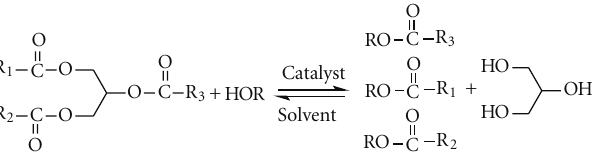
Figure 1: Schematic diagram of triacylglycerol transesterification by alcoholysis, in the presence of catalysts.